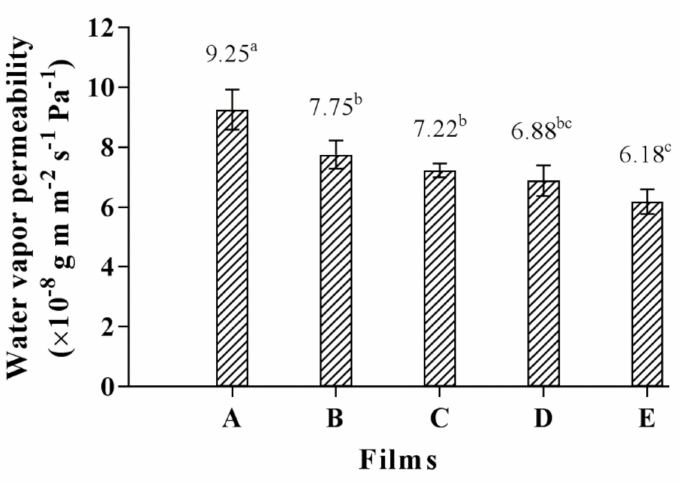
Figure 3. Water vapor permeability of ( A ) CMCy film, ( B ) CMCy75/RF25 composite film, ( C ) CMCy50/RF50 composite film, ( D ) CMCy25/RF75 composite film, and ( E ) RF film. Bars repre- sent the standard deviation ( n = 3). Different letters indicate the significant difference ( p <